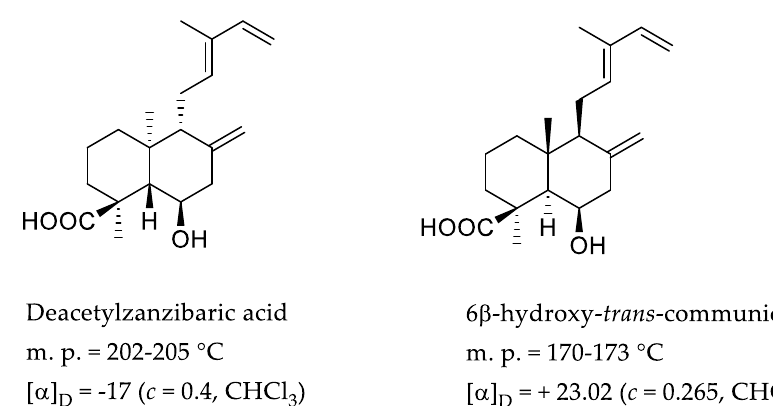
Figure 5. Comparison of some physical properties of deacetylzanzibaric acid with compound 2 .